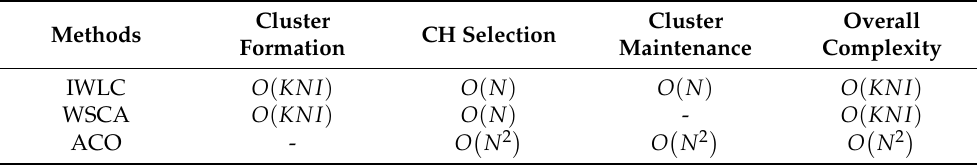
Table 5. Time complexity